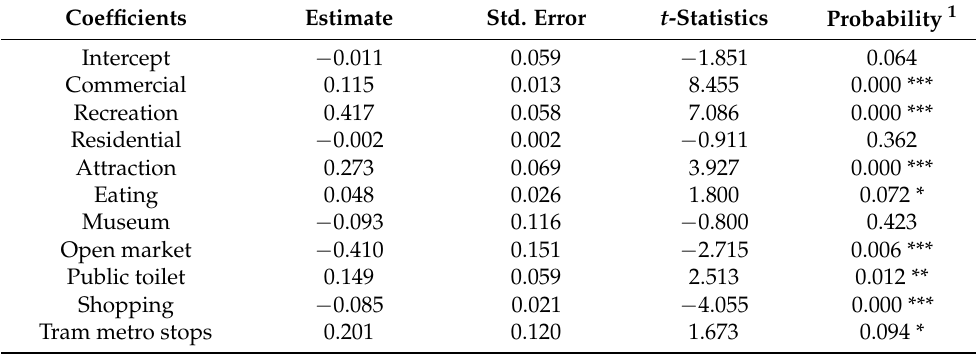
Table 4. OLS regression